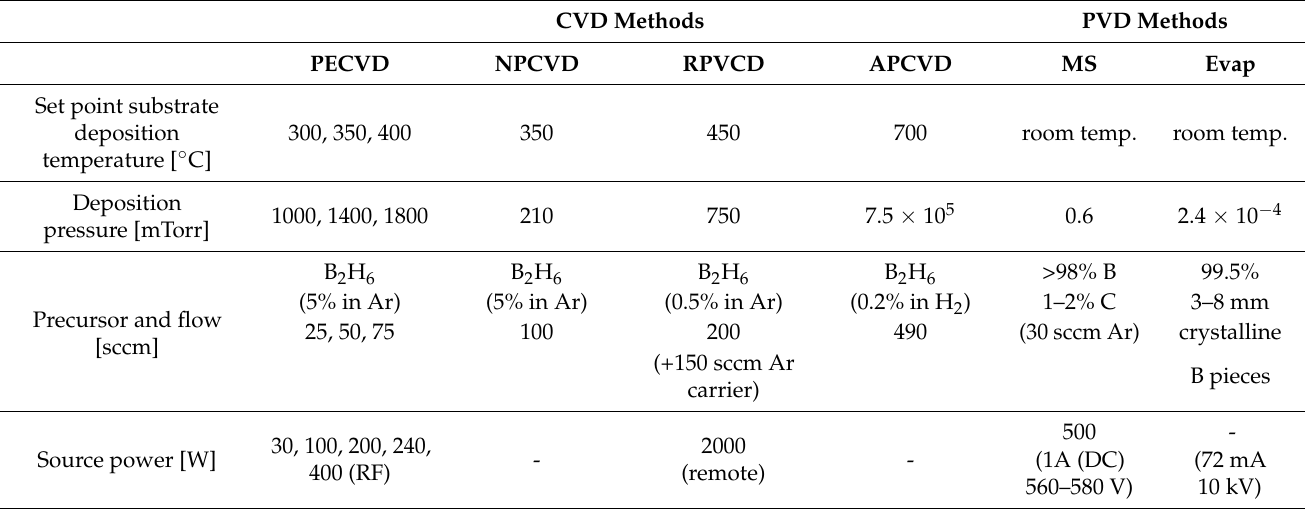
Table 1. Settings of the boron deposition methods as used in this work, i.e., plasma enhanced